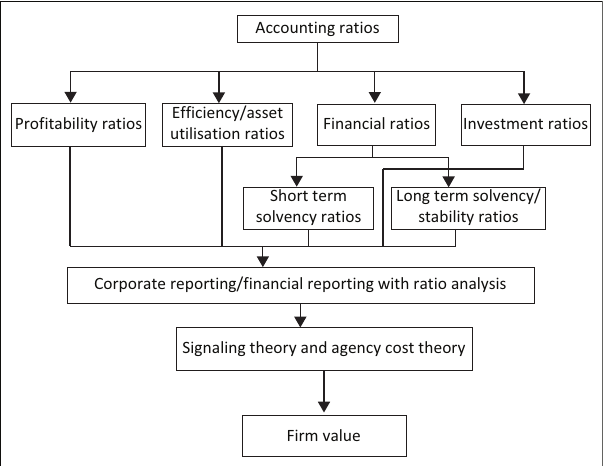
FIGURE 2: Interaction between accounting ratios and firm’s